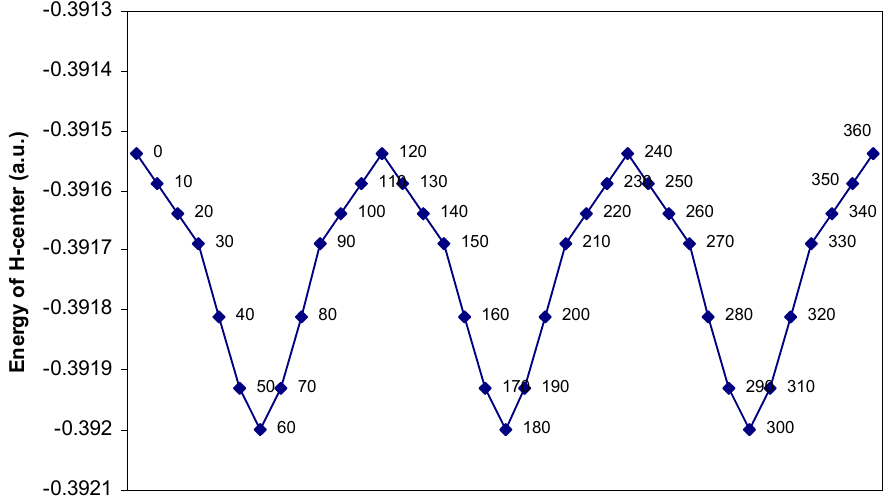
system as a function of torsional 3